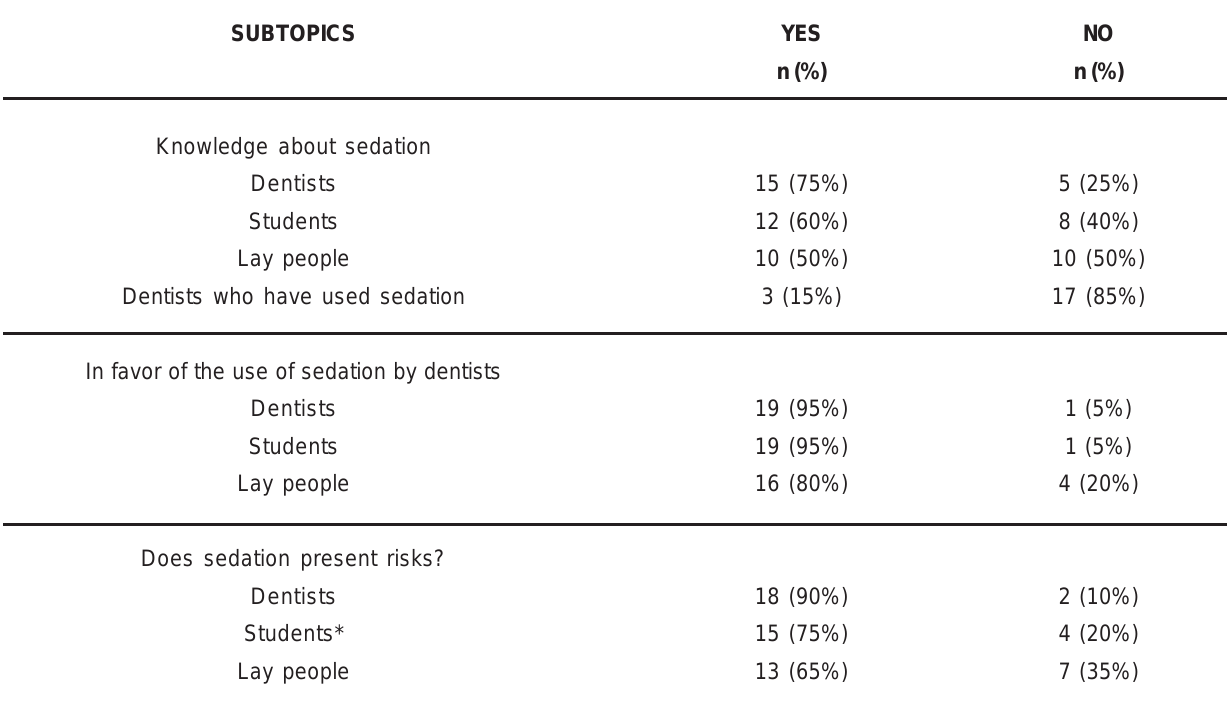
TABLE 1 - Absolute (n) and relative (%) frequencies of responses related to questions about sedation in